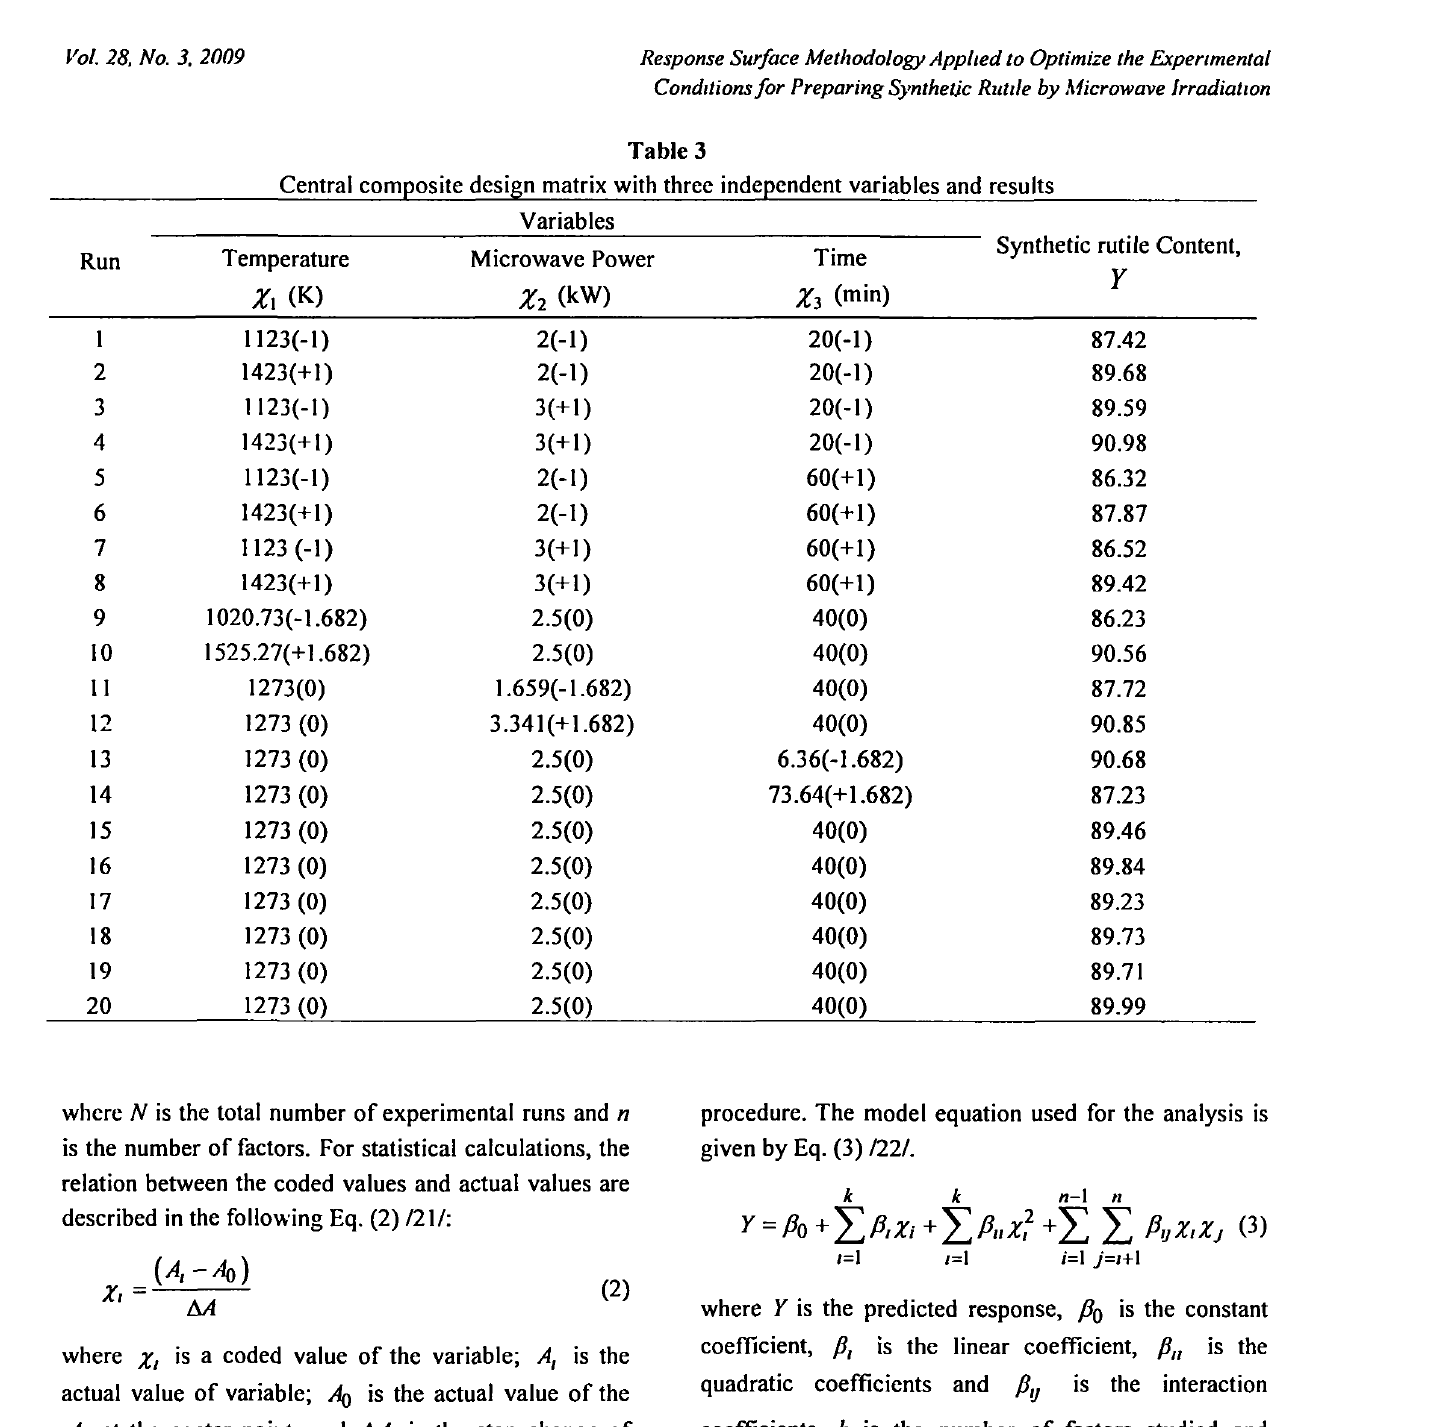
Central composite design matrix with three independent variables and